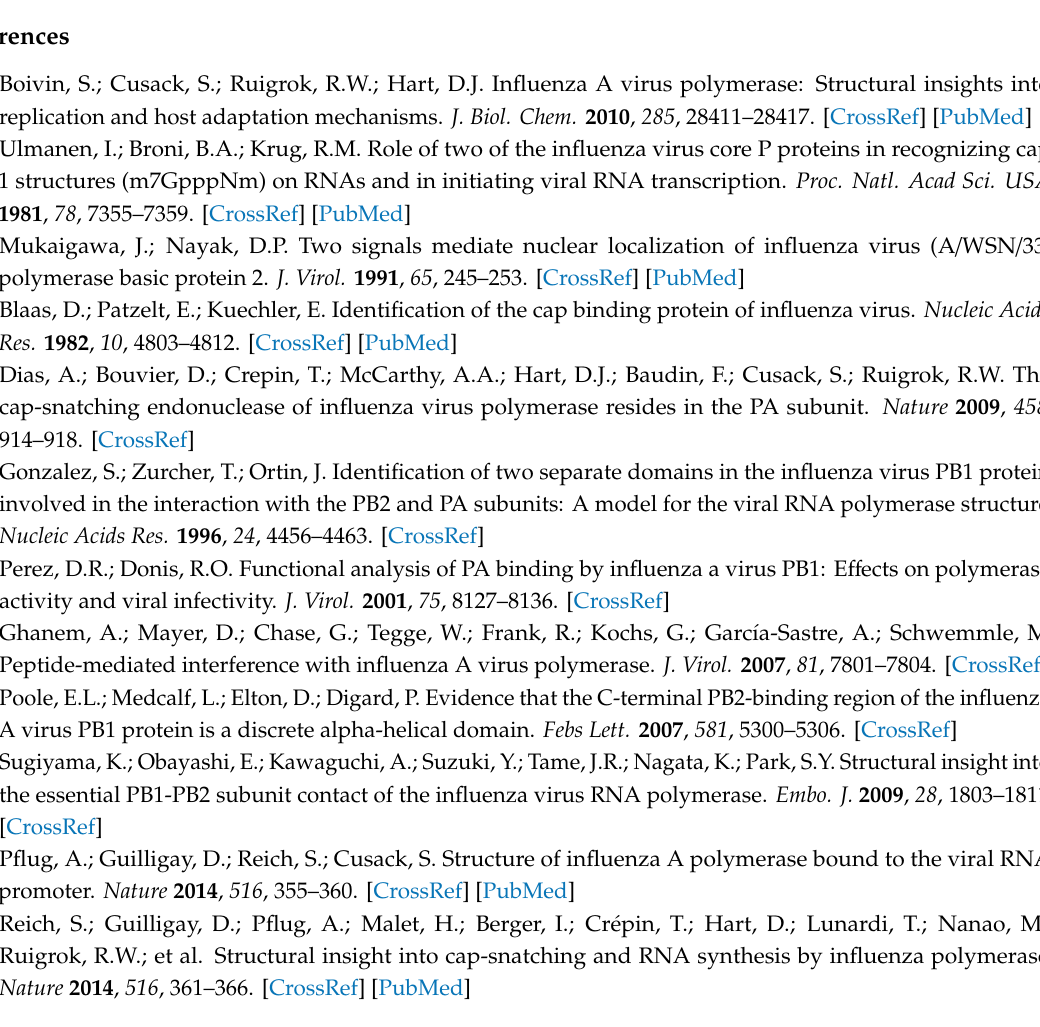
Figure S1. Distribution of the RNP and chromatin in the nucleus of H1N1 and H9N2 virus-infected cells; Figure S2. Distribution of the NP in virus-infected A549 cells; Figure S3. Expression of the recombinant polymerase genes of the H1N1 / WSN(H1N1), pH1N1 / 471 (pH1N1) or H9N2(H9N2) viruses; Figure S4. PA protein sequences; Figure S5. Lamin A / C and B1 distribution in influenza virus-infected cells. Figure S6. Increased apoptosis is not observed in H9N2 virus-infected A549 cells; Figure S7 Anti-NPC staining in influenza virus-infected cells; Table S1. List of virus-specific primers used in this